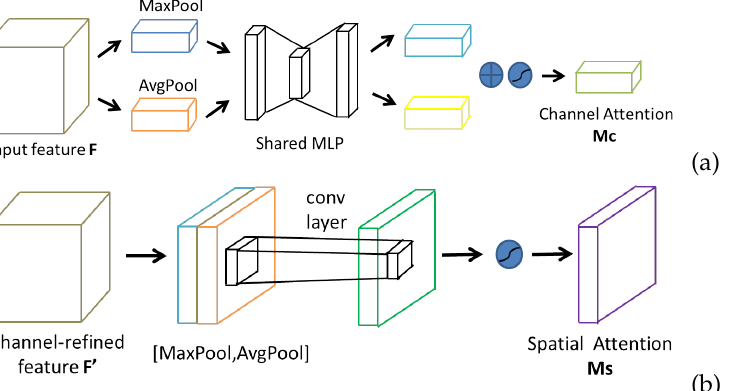
Figure 6. The Convolutional Block Attention Moudle: ( a ) Channel Attention Moudle. ( b ) Spatial Attention